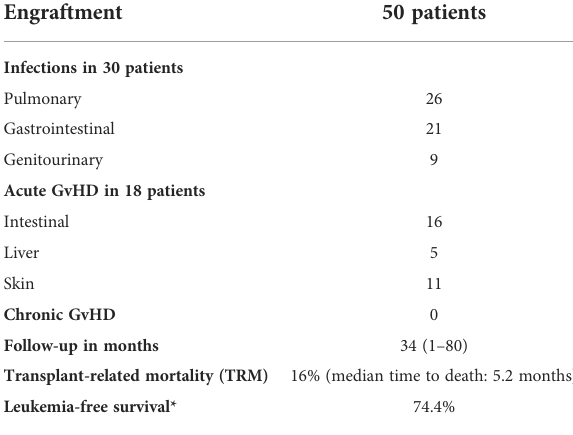
TABLE 3 Outcomes of TMLI and hematopoietic stem cell transplantation in 50 patients with hematologic malignancies. Engraftment 50